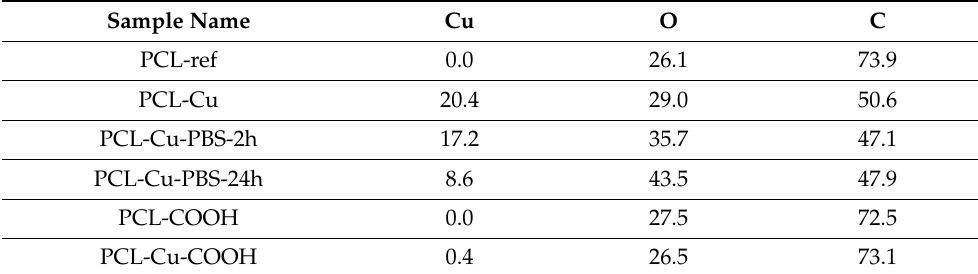
Figure 4. SEM micrograph ( a ) and EDS Cu signal cartography ( b ) of PCL-Cu sample. Table 2. Composition of samples (in at. %) derived from XPS analysis.